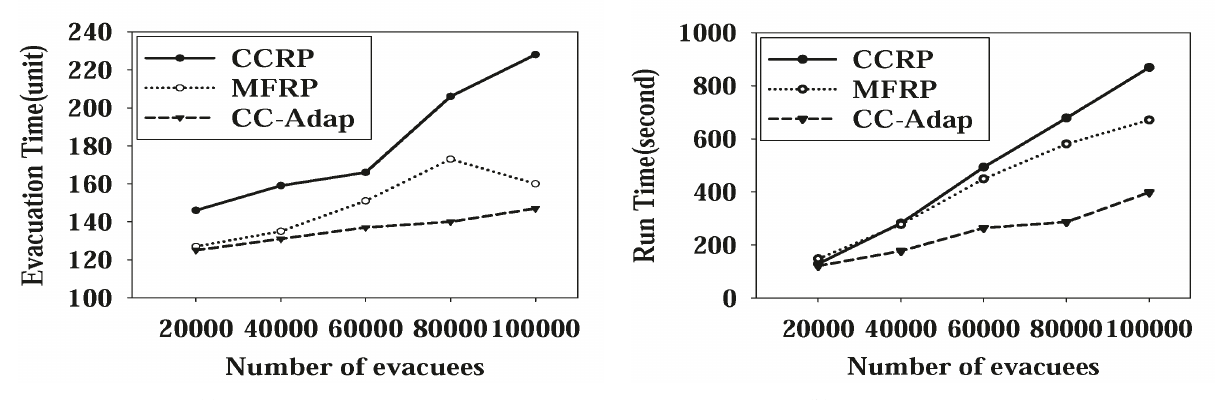
Figure 4: Evacuation quality in a small transportation network.